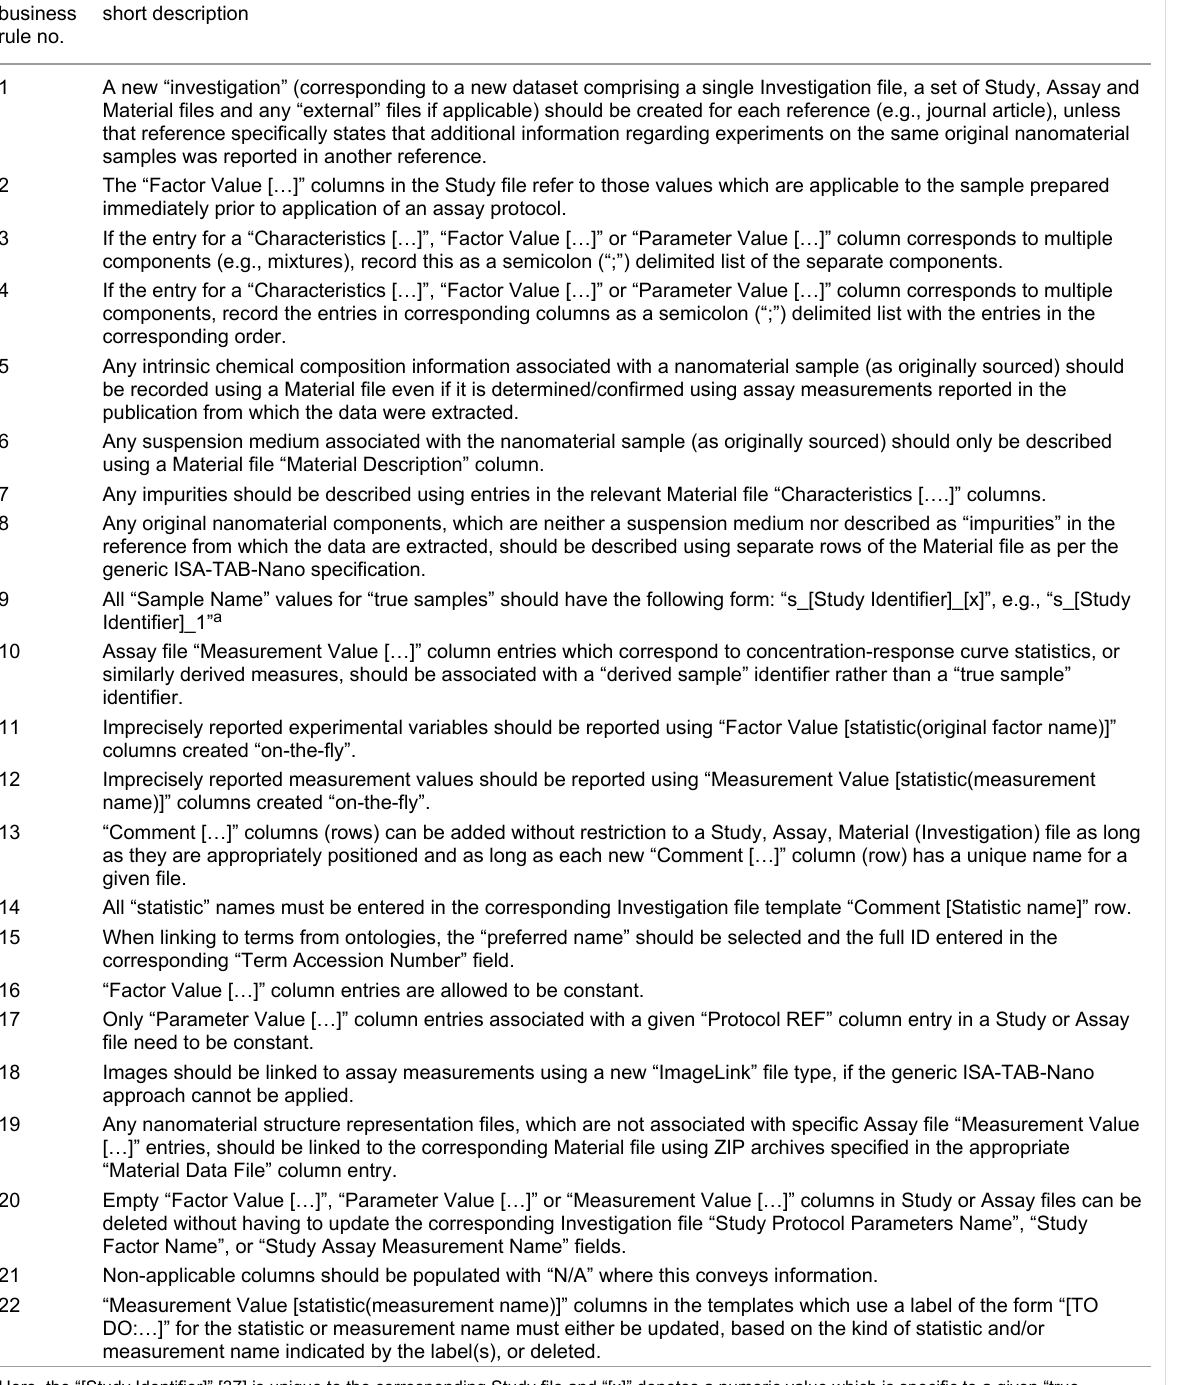
Table 3: Summary of the NanoPUZZLES business rules. business rule